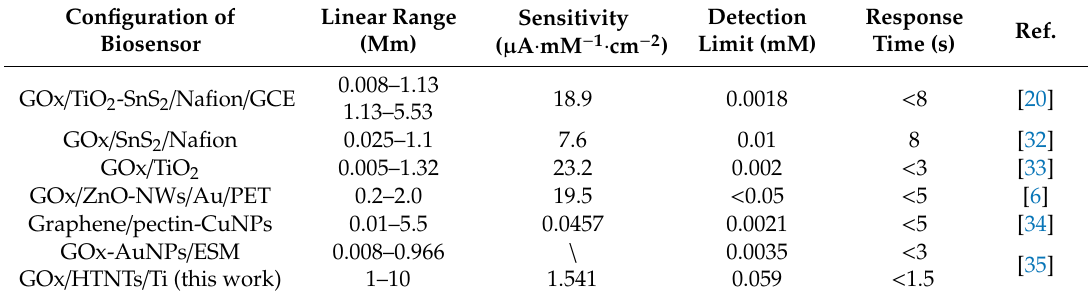
Table 1. Comparison of Various Glucose